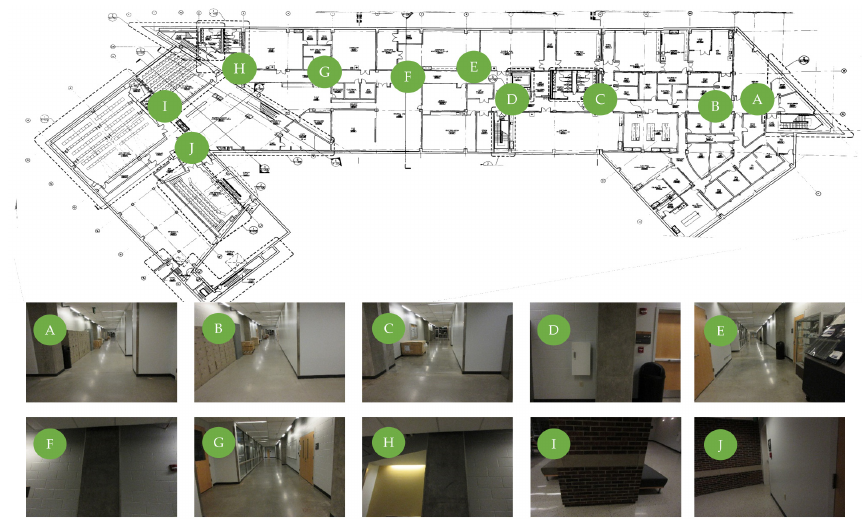
Figure 3. Path transformation: 10 images are matched with the corresponding locations on the reconstructed